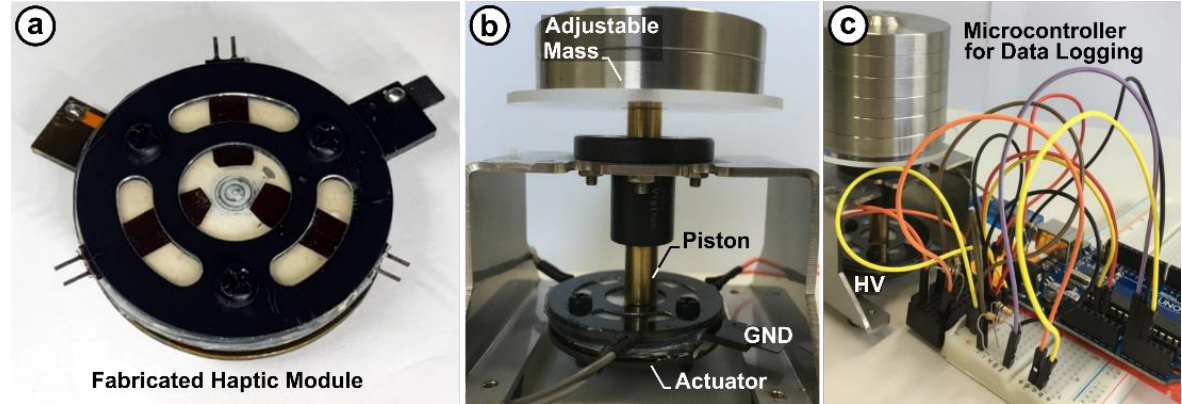
Figure 6. Static testing setup: ( a ) fabricated haptic module (ER actuator with embedded sensors); ( b ) test platform using adjustable masses to press the actuator; ( c ) sensing circuitry for logging the data over serial.